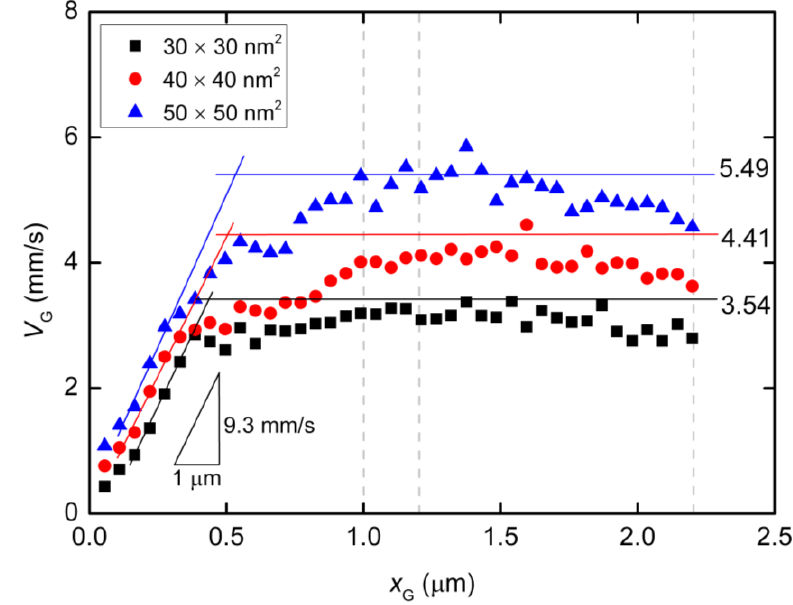
Figure 6. Velocity profile of the centers of mass of ssDNA chains passing through nanopores of cross-section 30 × 30, 40 × 40, and 50 × 50 nm 2 , in which x is the position G of mass center measured from the nanochannel entrance along the x -axis. The results of theoretical calculations using Equations (4) and (5) are shown as solid lines. The start and end of the nanopore are situated at x = 1.0 and 1.2 μm and the end of the nanochannel is at G x = 2.2 μm, all of which are indicated by dashed G